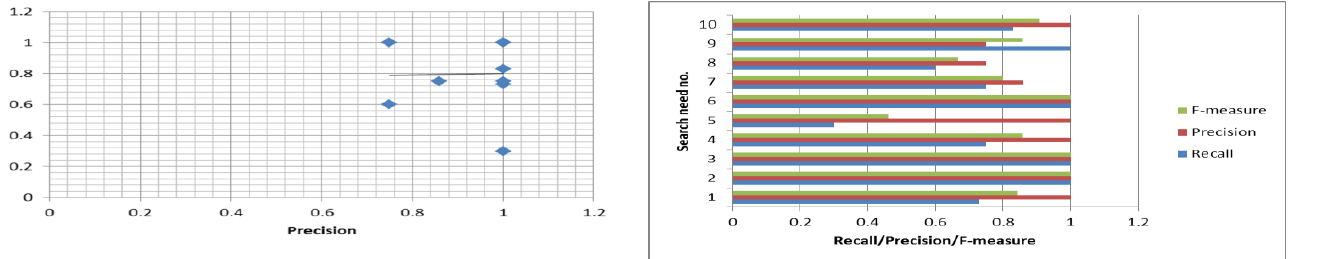
Fig. 17. A Bar graph of recall, precision and